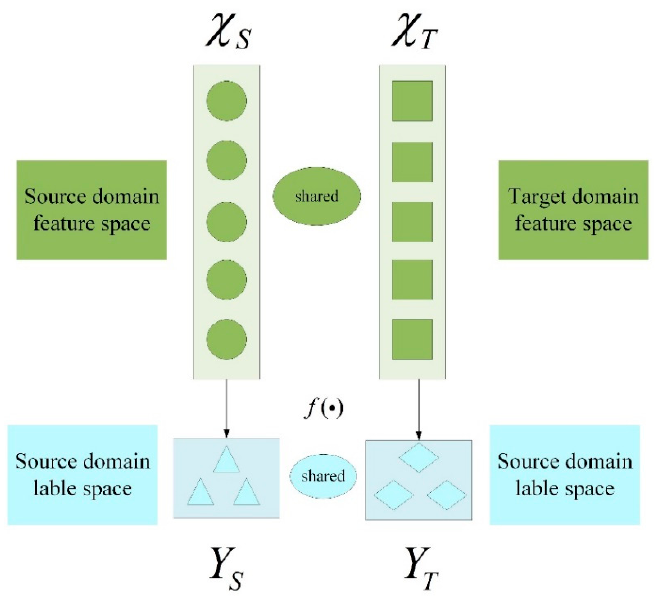
Figure 2. Domain Adaptive Schematic.